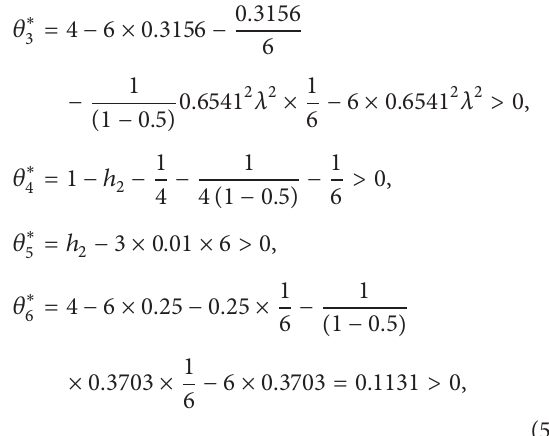
Since 𝜎(𝑊) = min {𝜎 1 (𝑊), 𝜎 2 (𝑊), 𝜎 3 (𝑊), 𝜎 4 (𝑊)} , we obtain 𝜎(𝑊) =